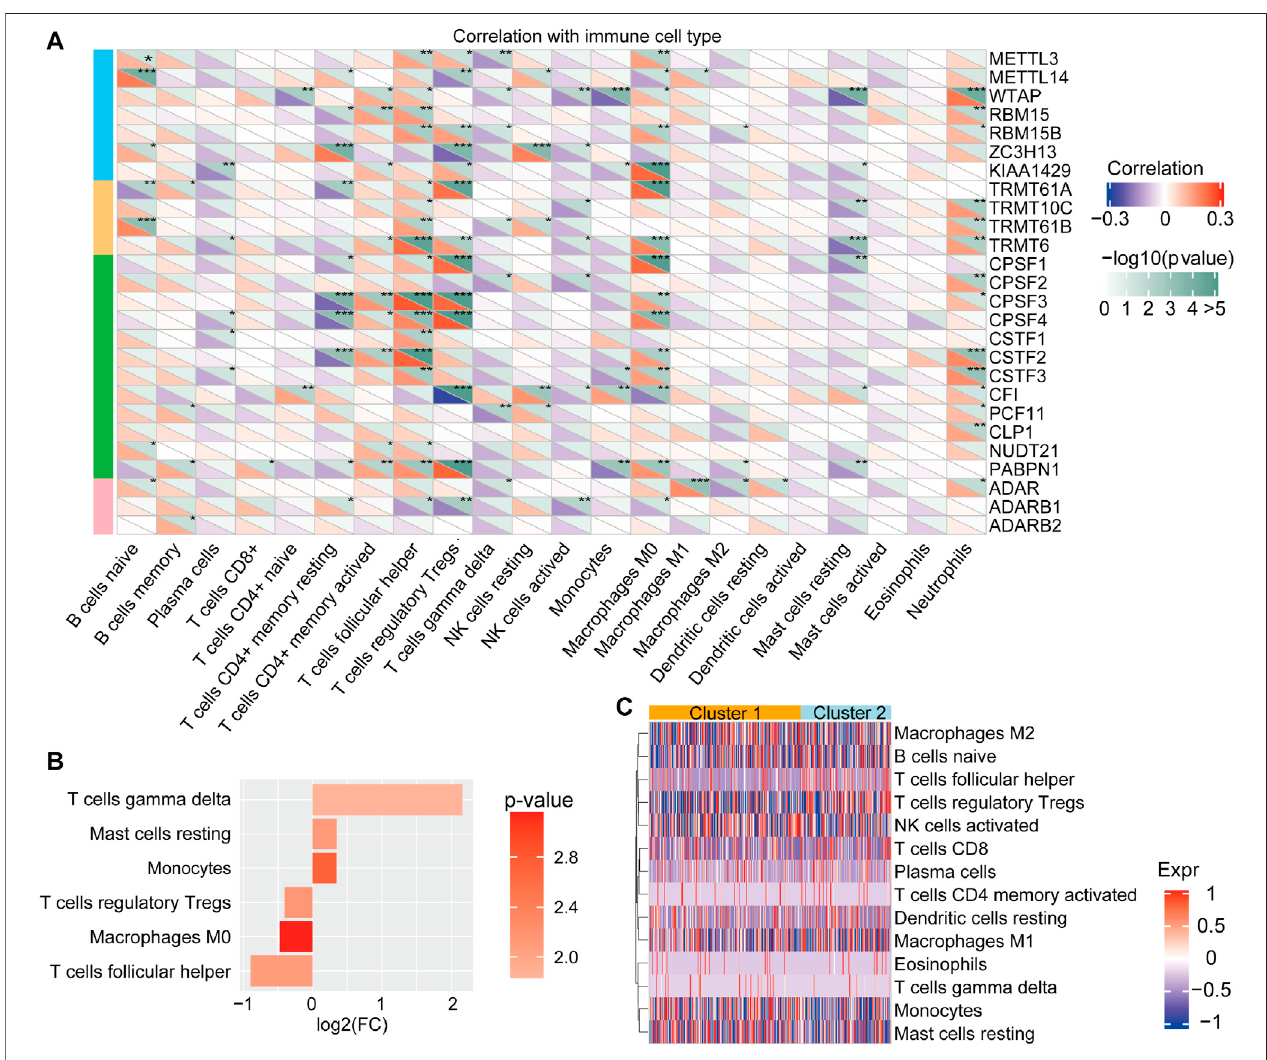
FIGURE3| TumorimmunemicroenvironmentcharacterizationoftheRNAmodi fi cationpatterns (A) Thecorrelationbetweenthe26 “ writers ” andTMEinHCCwas analyzed by CIBERSORT (B) The different characters of immune cell in fi ltration between clusters. Log(FC) > 0 represents that the immune cells were enriched in cluster 1 (C) The types of immune cells between distinct RNA modi fi cation patterns.